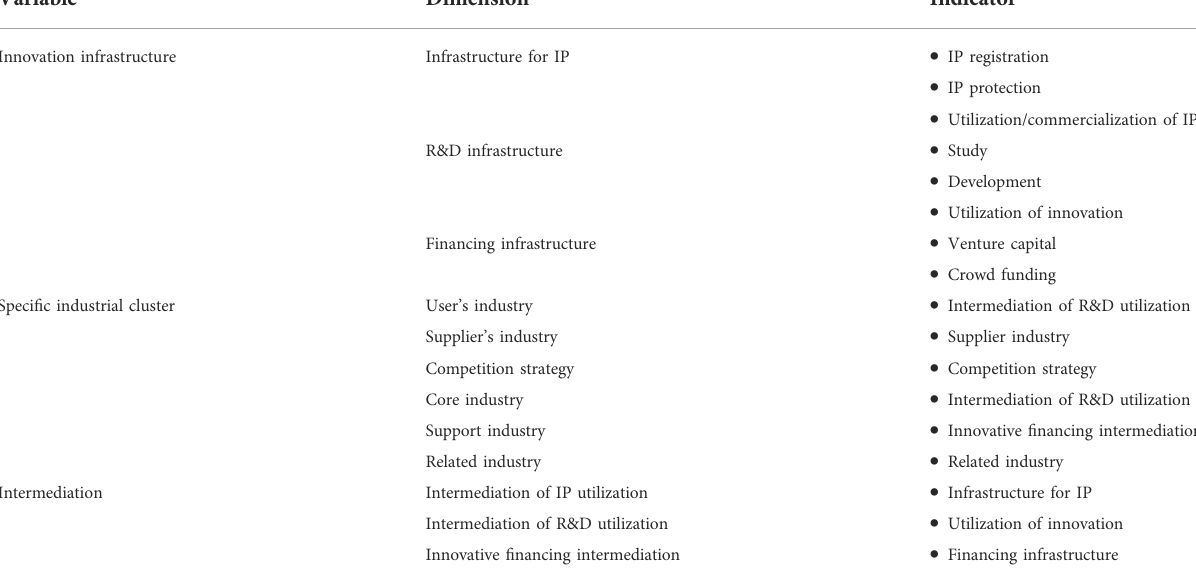
TABLE 1 Variable operationalization.